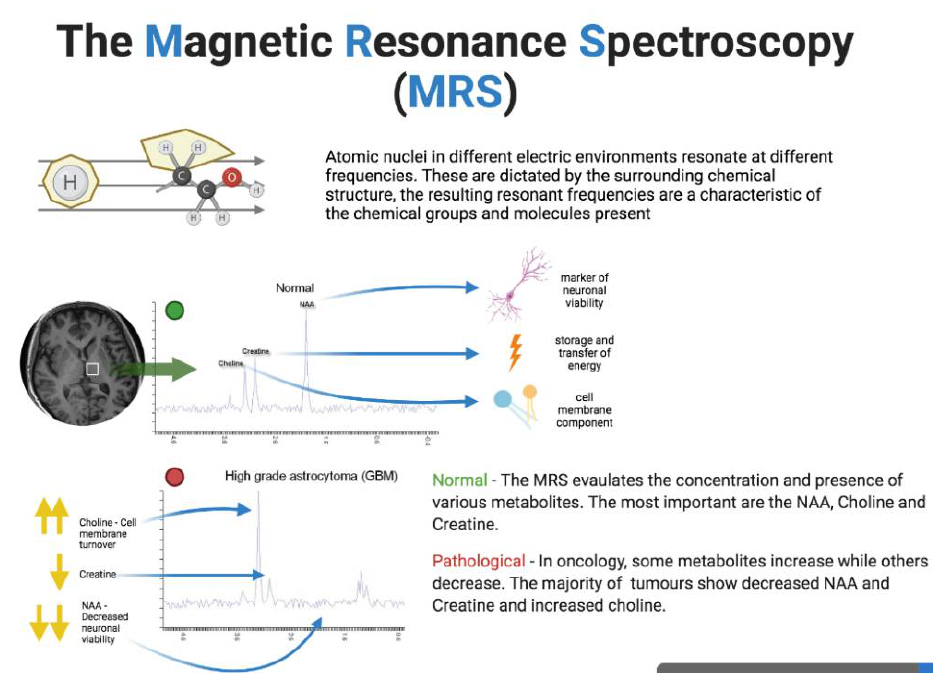
Figure 3. Physical principles of magnetic resonance spectroscopy (MRS). The figure was created with BioRender.com.